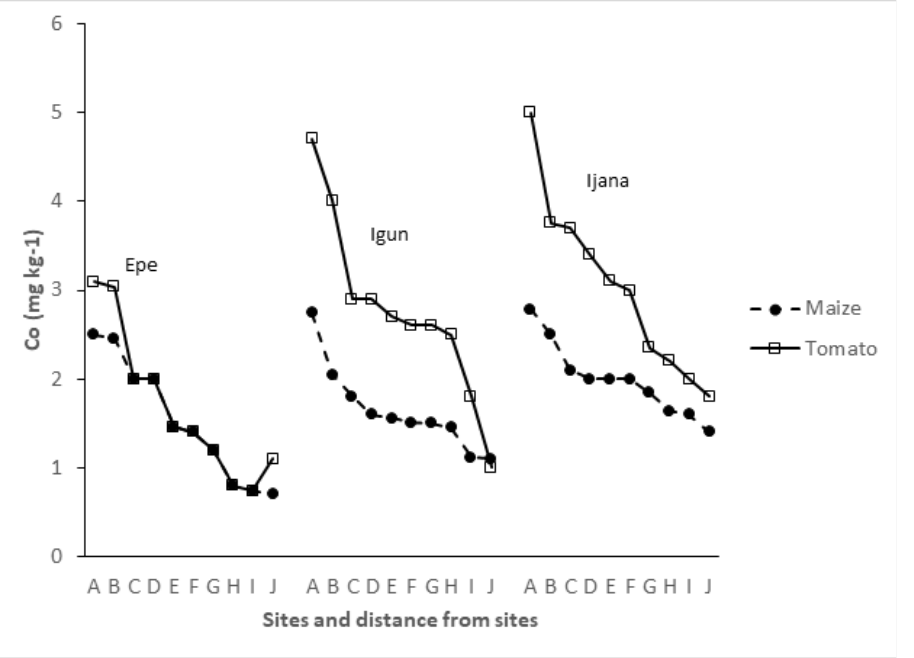
Figure 12: Concentrations of Coin maize and tomato crops at Epe, Igun & Ijana (0 – 900 m) sites. A = 0 m from site; B = 100 m from site; C = 200 m from site; D = 300 m from site; E = 400 m from site; F = 500 m from site; G = 600 m from site; H = 700 m from site; I = 800 m from site; J = 900 m from